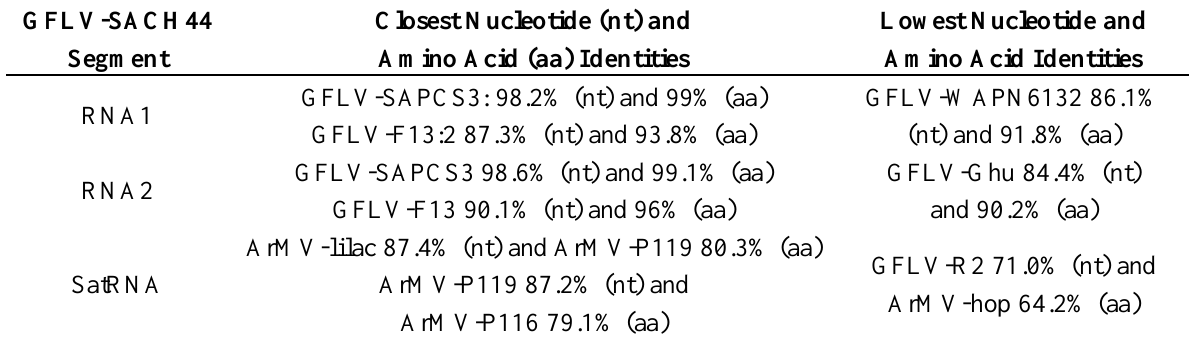
Table 1. Shared sequence identities (closest and most distant) of GFLV-SACH44 and other Grapevine fanleaf virus (GFLV) or Arabis mosaic virus (ArMV) full-length sequences. satRNA, satellite